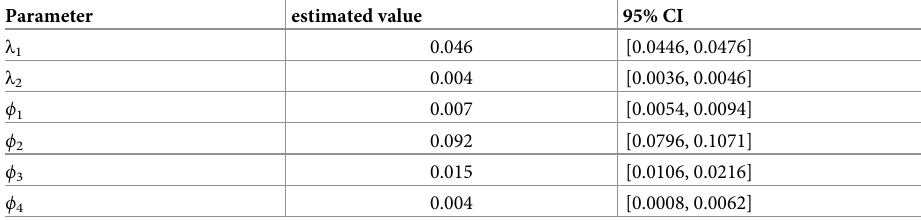
Table 2. The parameter estimates for the metastatic dissemination of ovarian